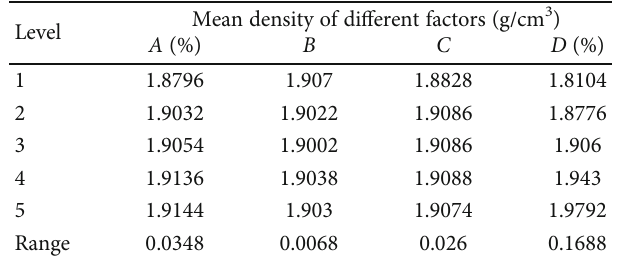
Table 3: Index parameters of the specimens. Table 4: Range analysis of the density of similar